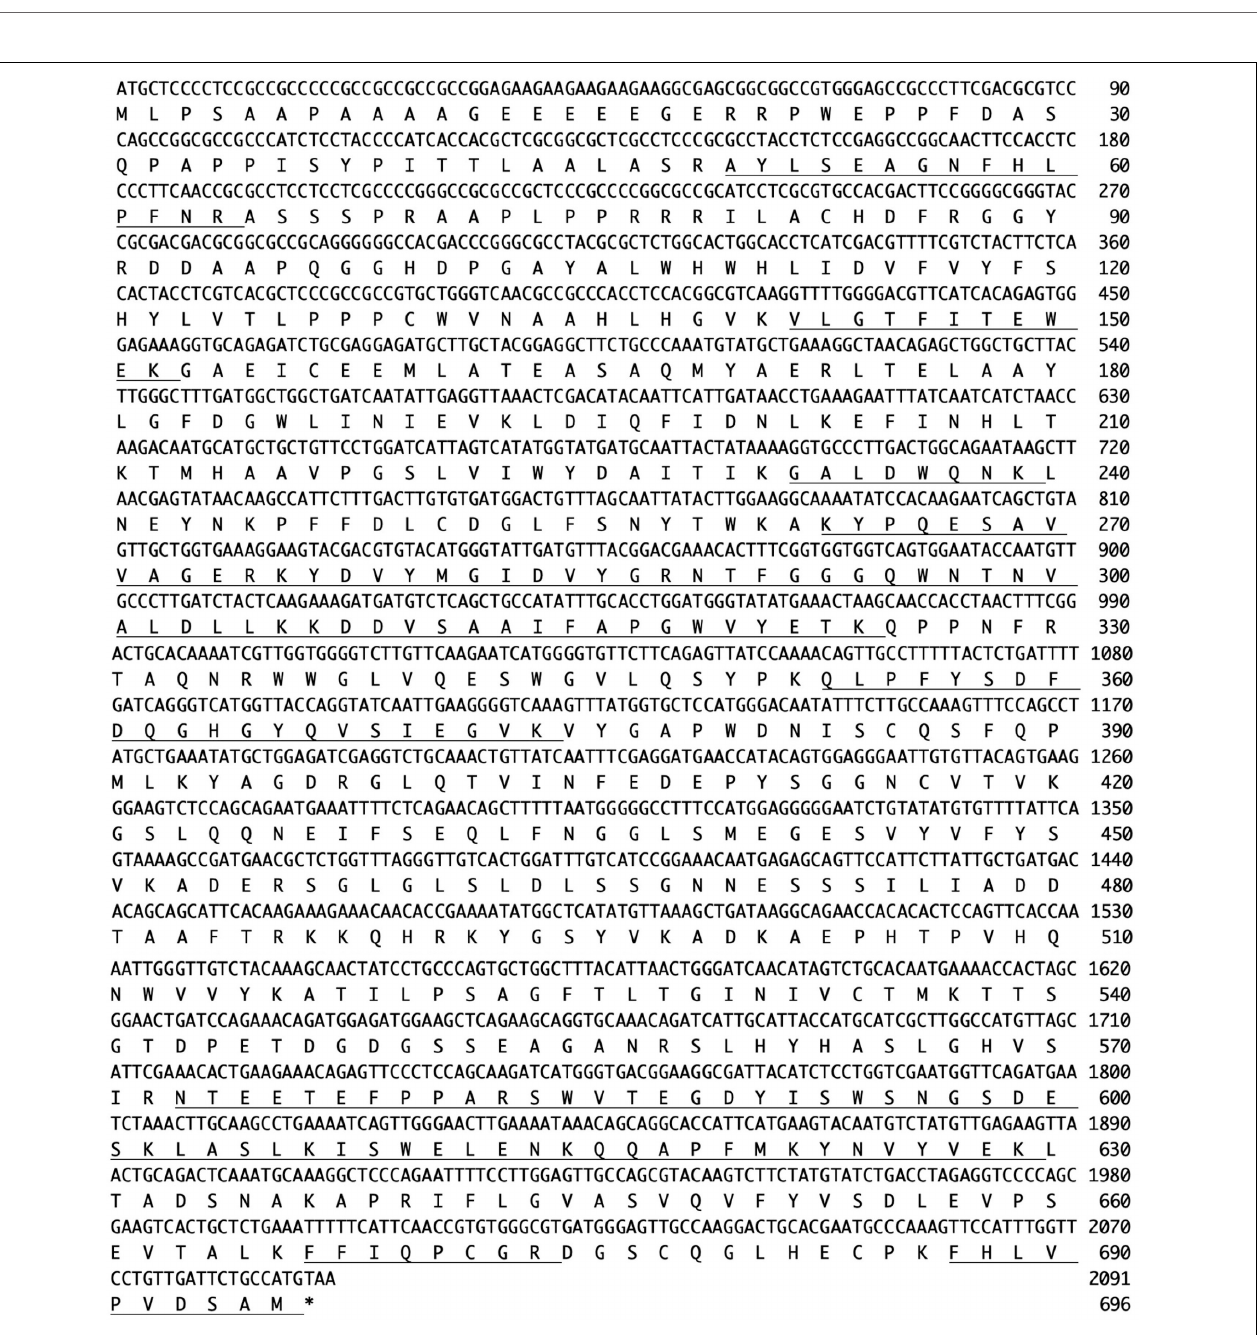
4GlcNAc β 1-4GlcNAc] and trisaccharide with only one